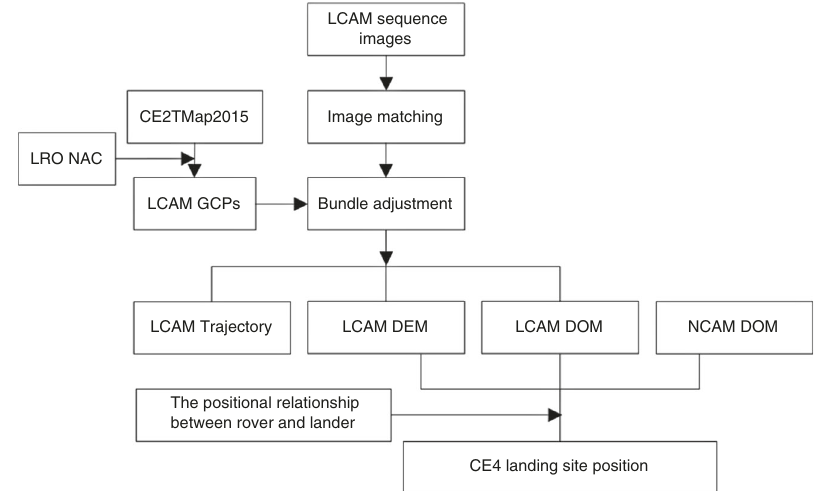
Fig. 8 Data processing fl